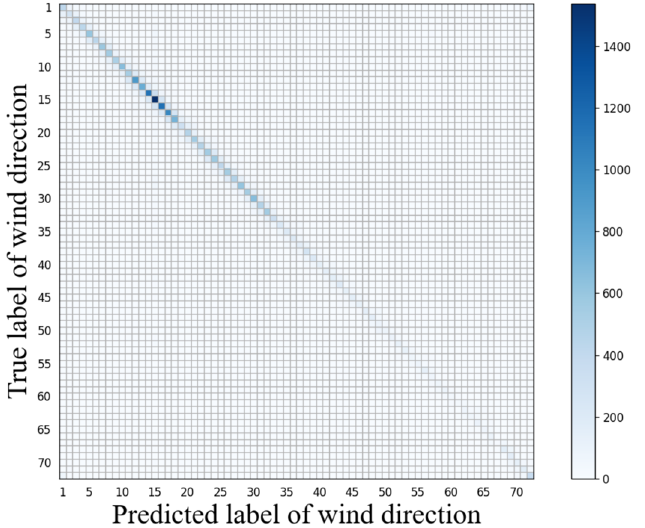
Figure 11. Confusion matrix dividing the distribution of SVM classification results into 72 retrievals with wind speeds greater than 10 m/s.